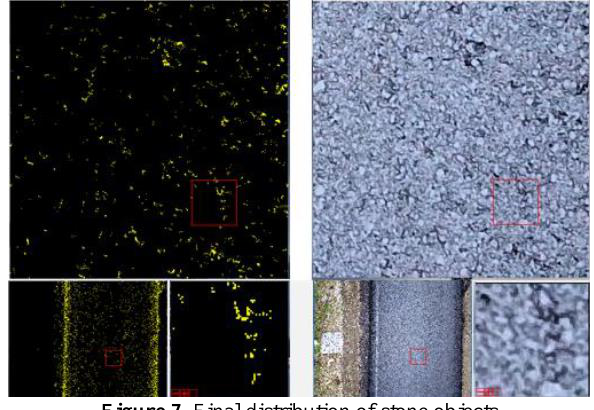
Figure 7. Final distribution of stone objects